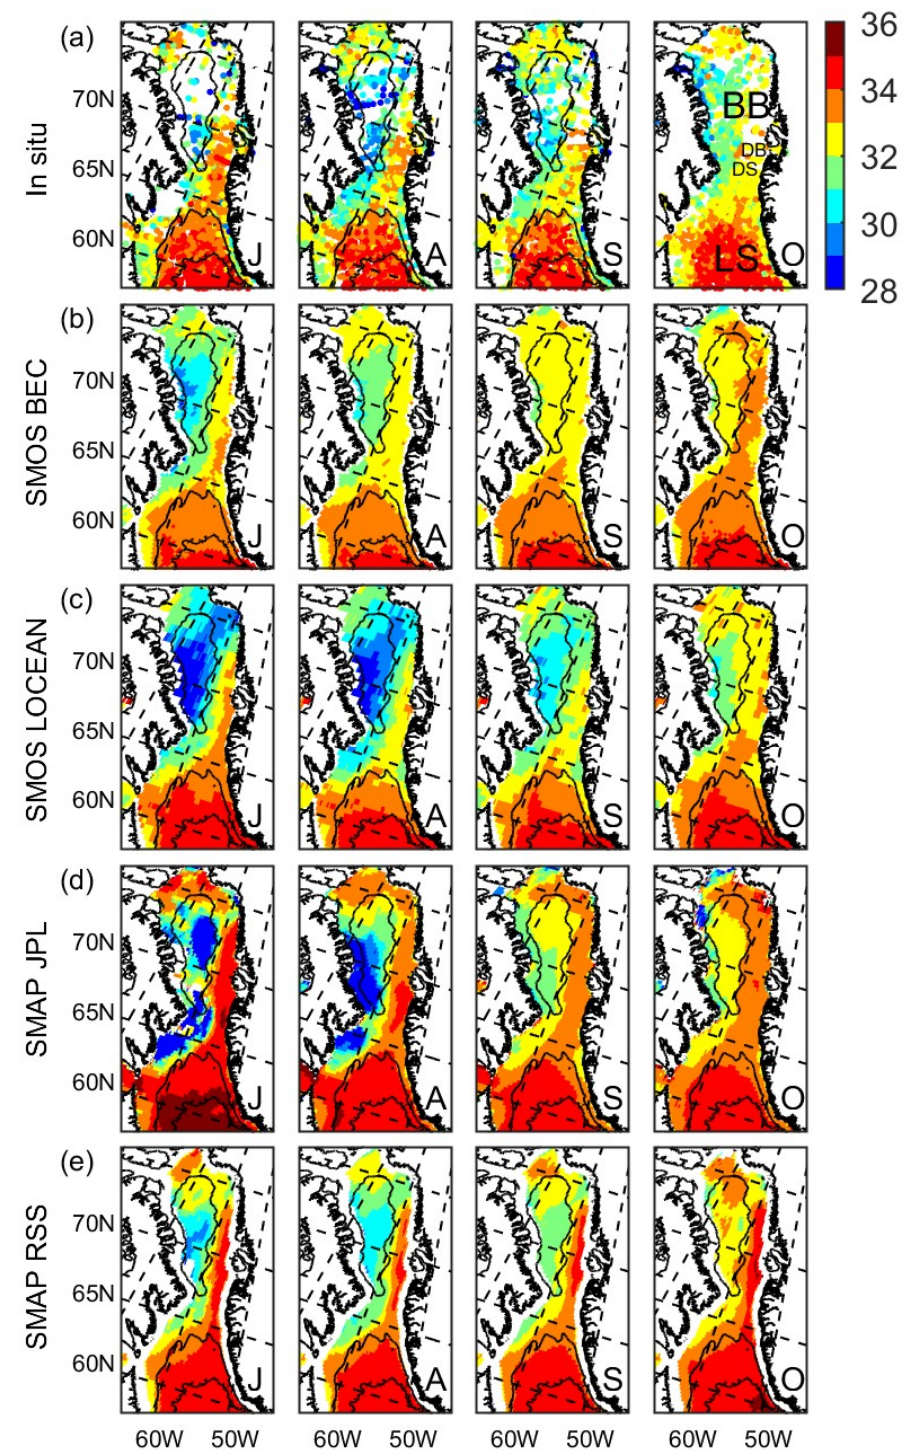
Figure 1. Monthly surface salinity in the Labrador Sea and Baffin Bay for July (J), August (A), September (S), and October (O) based on ( a ) in situ data, ( b ) SMOS BEC, ( c ) SMOS LOCEAN, ( d ) SMAP JPL, and ( e ) SMAP RSS. For in situ observations, all available data for a given month are plotted, while for satellite observations monthly averages are shown. Labels on top right panel indicate BB: Baffin Bay; LS: Labrador Sea; DS: Davis Strait; DB: Disko Bay.